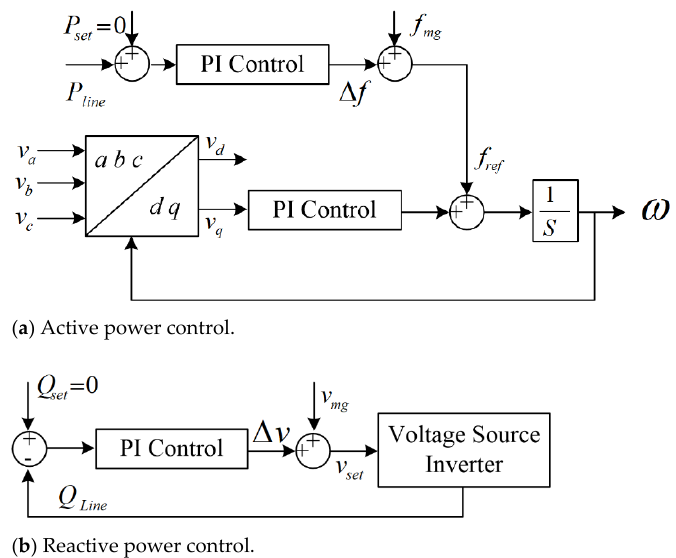
Figure 8. Control loop to set active and reactive power during intentional islanding.